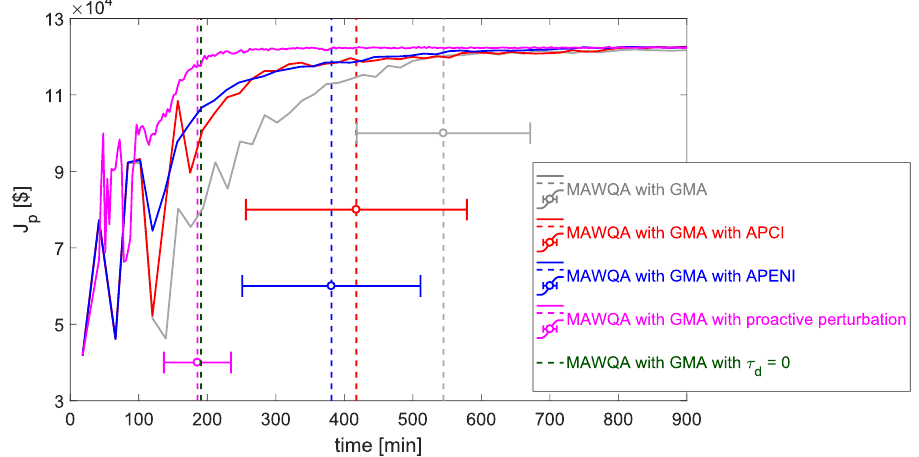
Figure 12. Lithiation reaction case study: evolution of mean profit function (solid lines), mean time of convergence (vertical dashed lines), and standard deviations of time of